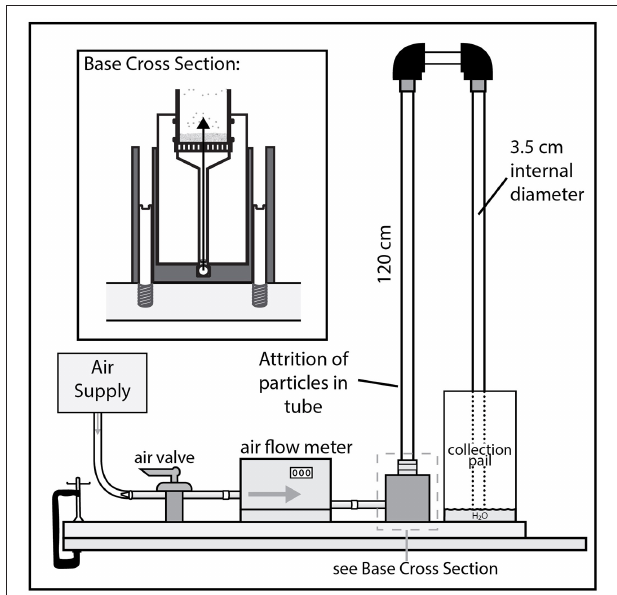
FIGURE 1 | A schematic diagram of the experimental apparatus used in this study. A fluidized bed where gas is supplied from a compressed air supply through a calibrated flow meter, at a user-determined flow rate, into the attrition tube where the particle collisions take place. A series of tubes, connectors, and a water reservoir ensure the successful recovery of all the products. Figure modified from Jones and Russell